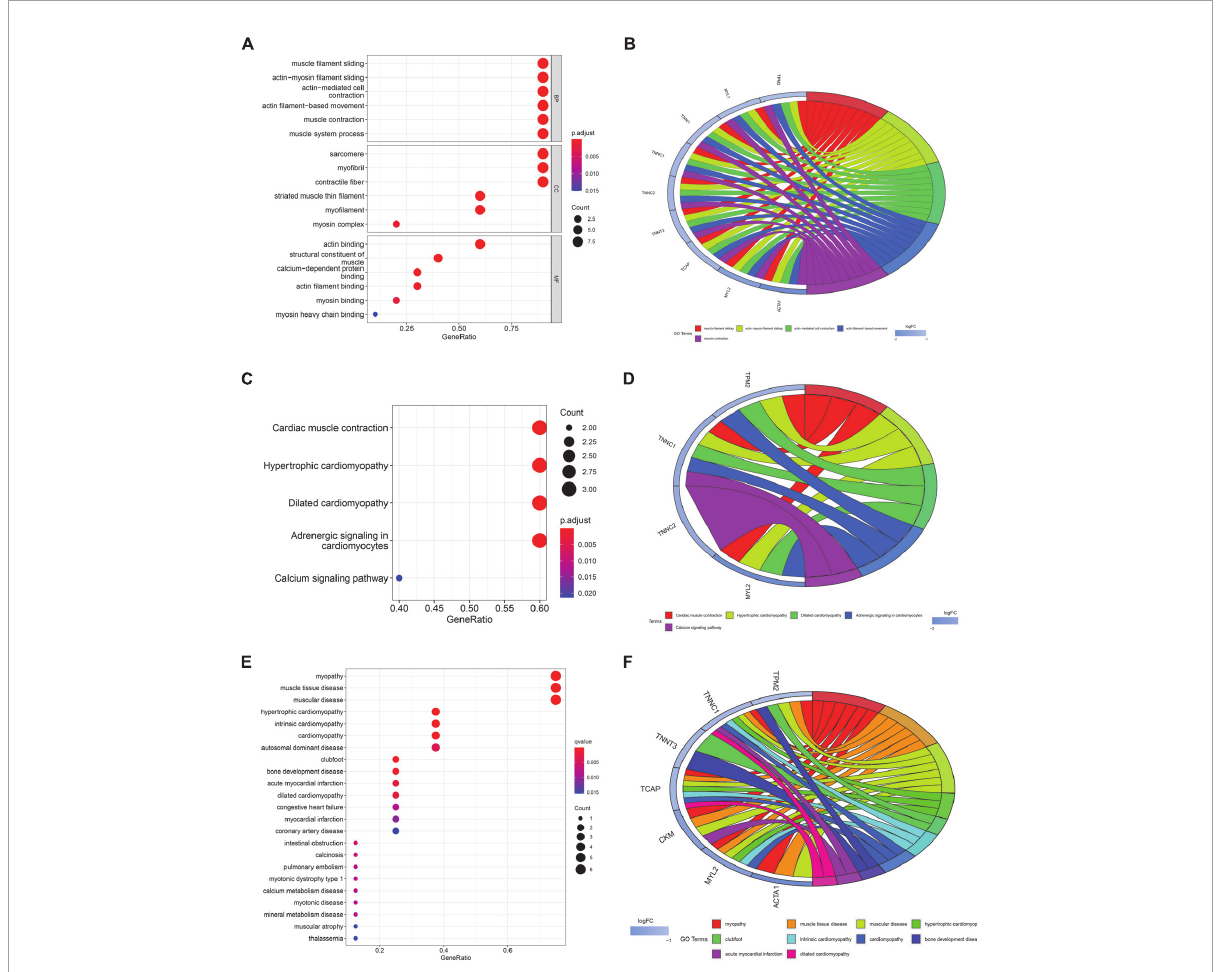
FIGURE2 Function, pathway, and disease enrichment analysis of core genes. (A) Bubble plot of GO function enrichment for core genes. (BP, Biological Process; CC, Cellular Components; MF, Molecular Function). (B) Circle plot of GO functional enrichment. (C) Bubble map of KEGG pathway enrichment for core genes. (D) Circle plot of KEGG enrichment analysis. (E) Bubble plot of DO enrichment for core genes. (F) Circle plot of DO enrichment analysis. The size of bubbles in the bubble plot represents the number of core genes in the corresponding pathway. The color of the bubbles represents the adjusted p -value. The circle plot illustrates certain core genes corresponding to the GO/KEGG terminology or disease. LogFC represents the expression level of